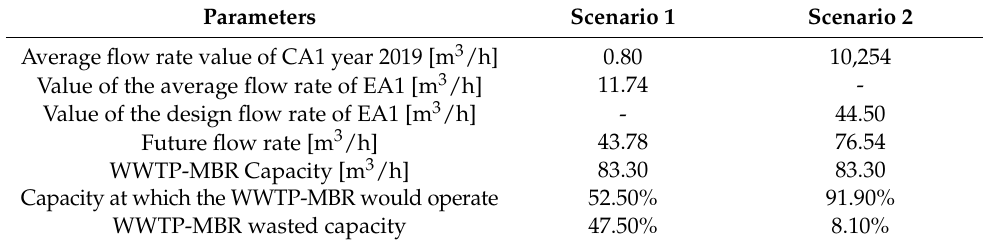
Table 17. MBR plant capacity.